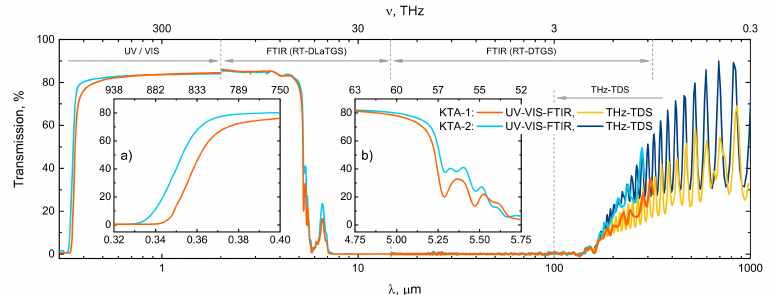
Figure 1. Combined transmission spectra of the KTA samples measured by three spectroscopic methods. Orange and sky-blue lines represent UV / VIS and FTIR data for KTA-1 and KTA-2 samples, respectively. Yellow and navy-blue lines represent adapted THz-TDS data for KTA-1 and KTA-2 samples, respectively. Gray arrows indicate spectral ranges of the spectrometers and used detectors (for FTIR). Insets ( a , b ) show zoomed regions of UV and IR cuto ff